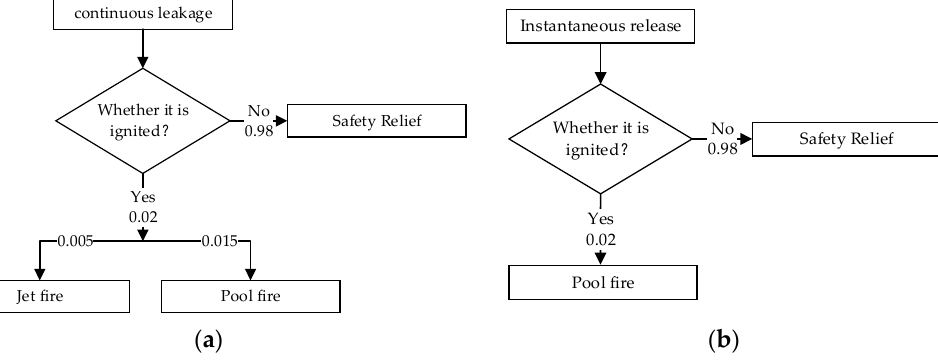
Figure 5. ( a ) Event tree of equipment failure consequence in case of continuous leakage; ( b ) Event tree of equipment failure consequence in case of instantaneous